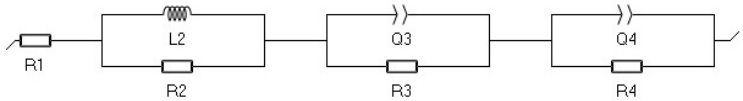
Figure 1. Nyquist equivalent circuit of Li-Ion cell used for data fitting in Ec-Lab.